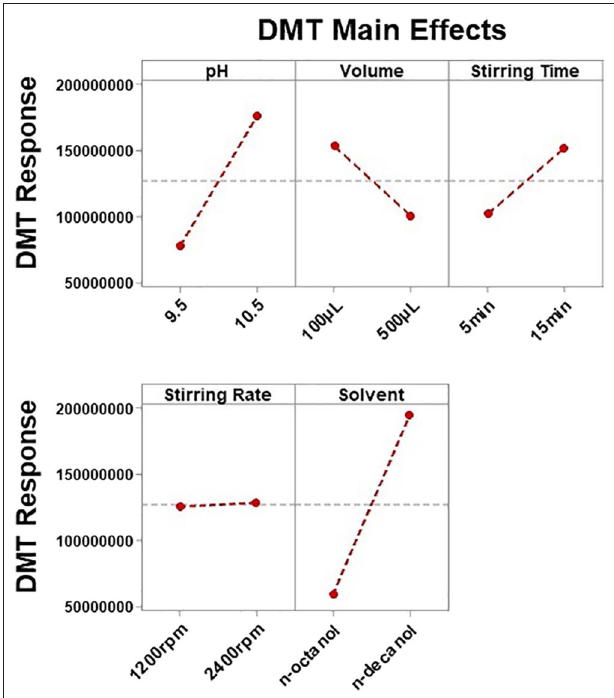
FIGURE 3 | Main effect plots for dimethyltryptamine (DMT) showing the influence of each evaluated variable on absolute response